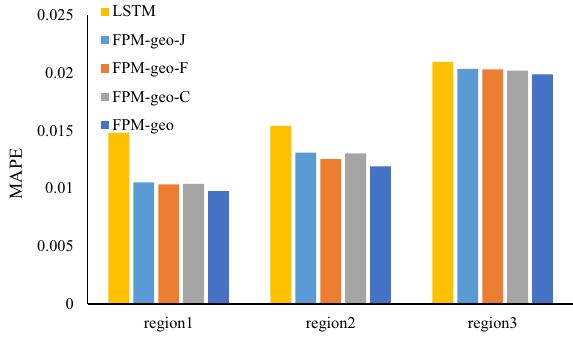
Figure 5. MAPEs of typical regions with different considered spatial relationships.